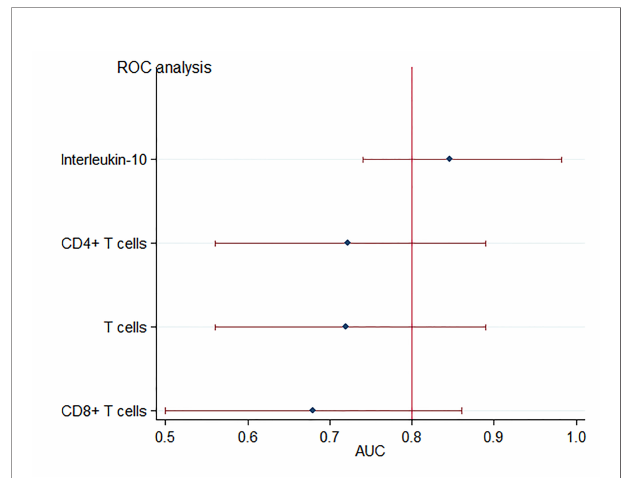
FIGURE 2 | Forest plot for accuracy of IL-10 and T cells in predicting critical illness relate dto COVID-19 pneumonia. Each marker is plotted as an area under the curve (AUC) of the receiver operating characteristic curve, with a 95% con fi dence